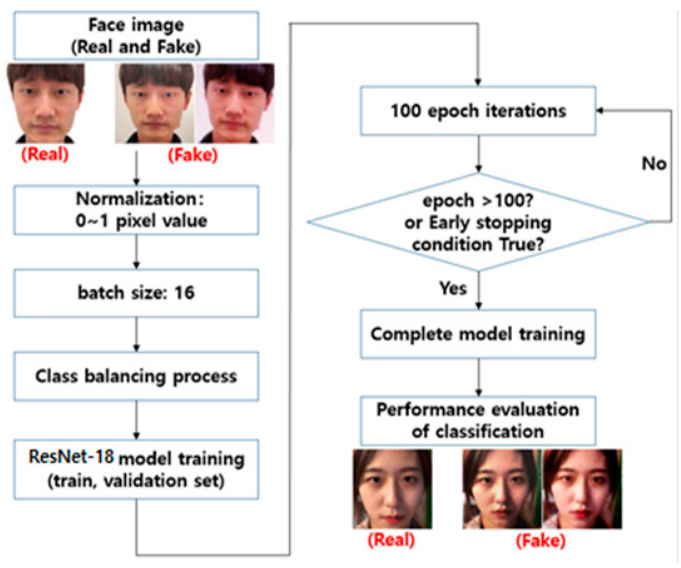
Figure 10. Flowchart of the proposed method for classification.